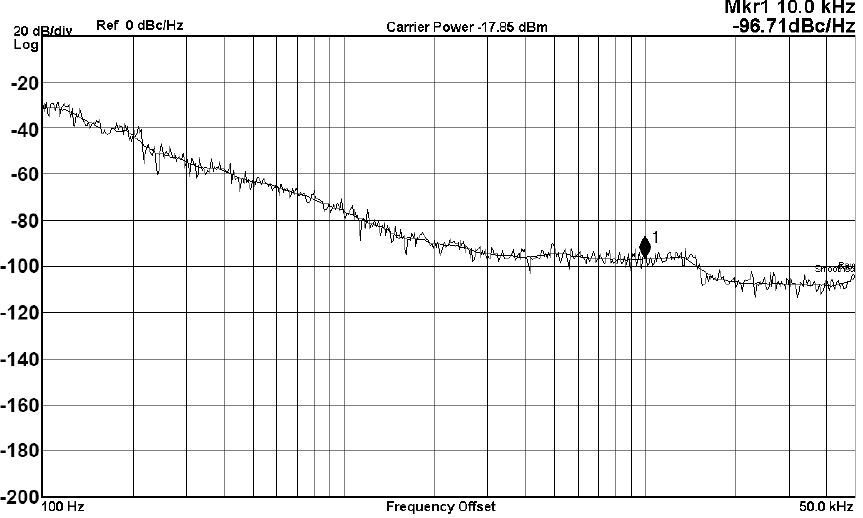
Figure 28. The measured phase noise of the VM quadrature oscillator at 1 kHz offset.